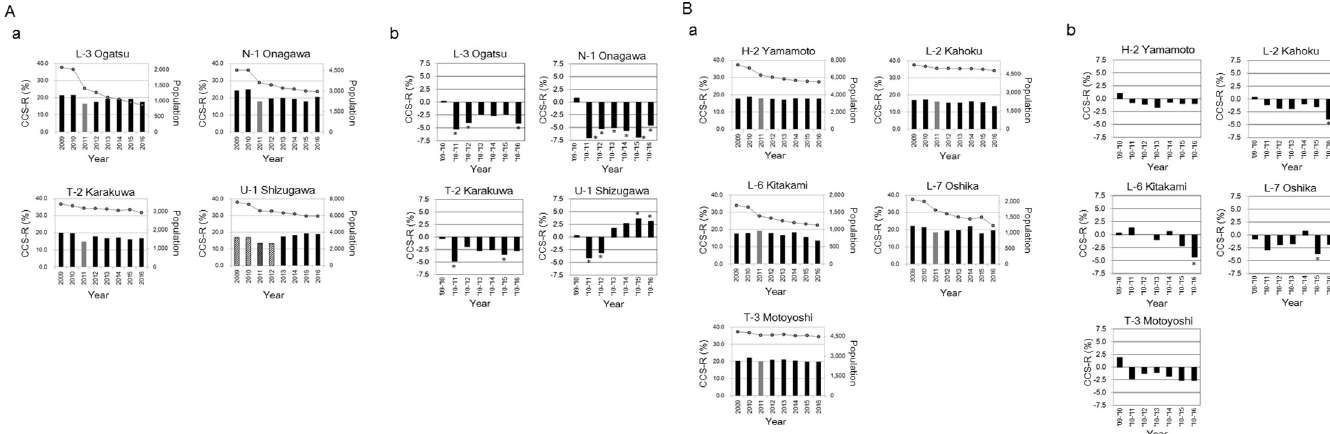
Fig 2. Change in the CCS-R in coastal areas. (A) a. Coastal areas showing a remarkable decrease in the cervical cancer screening rates (CCS-Rs) in the year following the Great East Japan Earthquake (over − 3.0%). The bar graph shows the CCS-R (%), and the line graph shows the population (number of people). b. Differences in the CCS-R between before and after the Great East Japan Earthquake in each area demonstrated in “a”. � , change of 3% or more. U-1 since Shizugawa (U-1a) and Utatsu (U- 1b) were integrated in 2013; the data for 2009–2012 include a total of two regions. (B) a. Change in CCS-R in other coastal areas. The bar graph shows the CCS-R (%), and the line graph shows the population (number of people). b. Differences in the CCS-R between before and after the Great East Japan Earthquake in each area demonstrated in “a”. � , change of 3% or more.